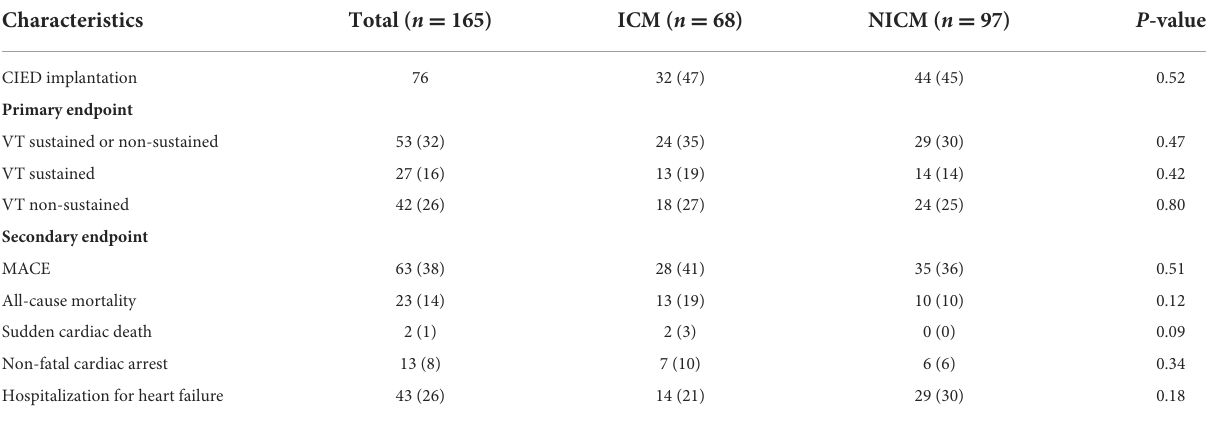
TABLE 3 Long-term outcomes of the